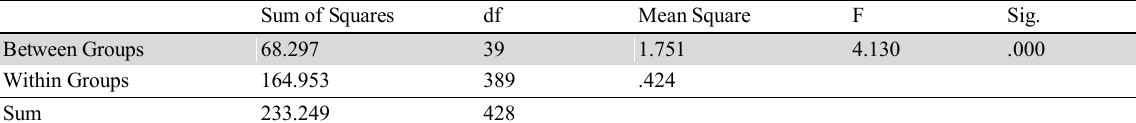
The summary of ANOVA test